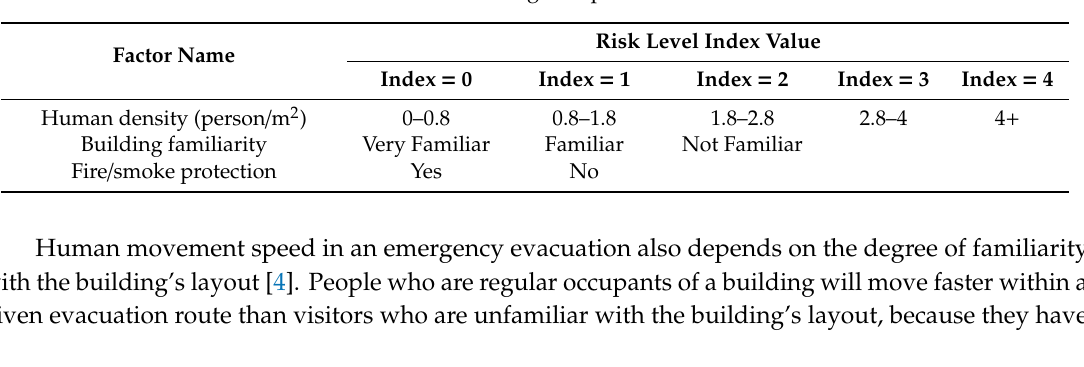
Table 2. Factors related to building occupants and their index